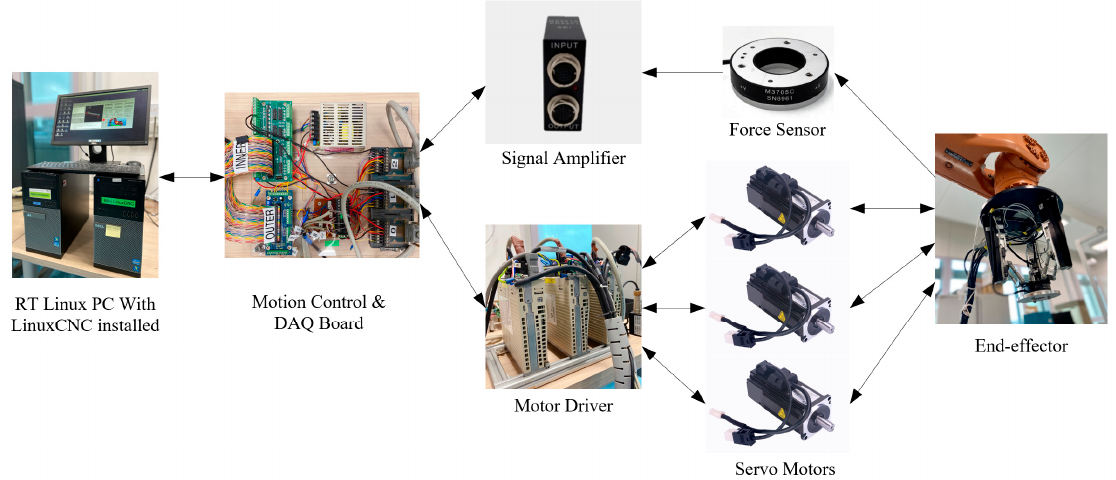
Figure 9. The structure of the end-e ff ector’s hardware control platform.